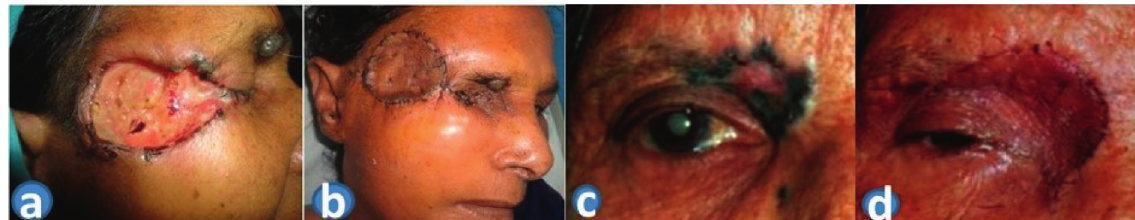
Figure 6: Surgical outcome (exenteration with excision biopsy followed by skin graft) of locally advanced basal cell carcinoma (a,b), and the result of excision biopsy with skin graft of morpheaform basal cell carcinoma